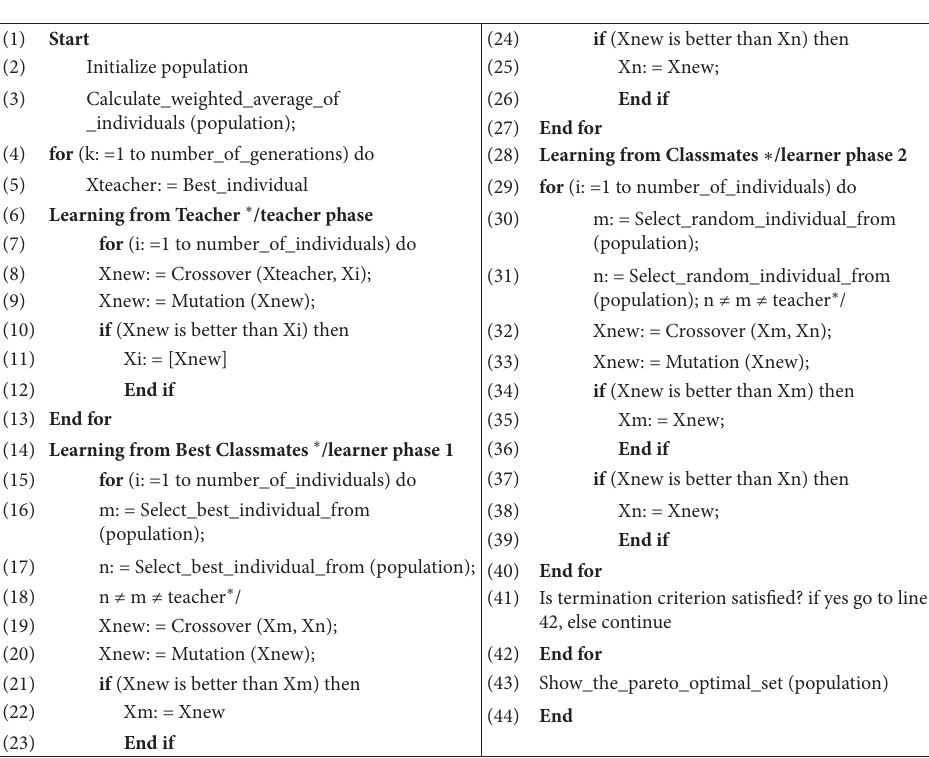
Figure 5: ITLBO algorithm.